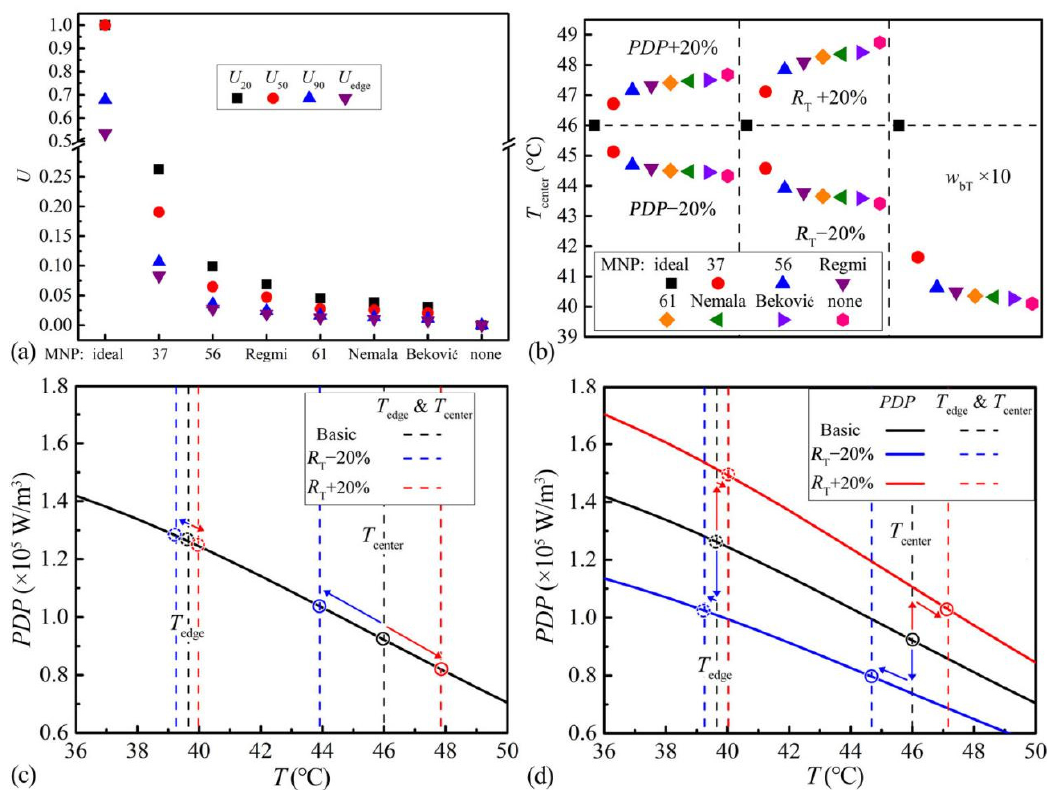
Figure 7. ( a ) Temperature uniformities ( U ) of the ZnCoCrFeO MNPs, the MNPs from references, MNP ideal and MNP none . ( b ) Stabilities ( T center changes) under PDP , R T and w bT fluctuations of the ZnCoCrFeO MNPs, the MNPs from references, MNP ideal and MNP none ; ( c ) Changes of temperature ranges of the MNP 56 under R T fluctuations; ( d ) Changes of temperature ranges and PDP - T curves of the MNP 56 under PDP fluctuations.